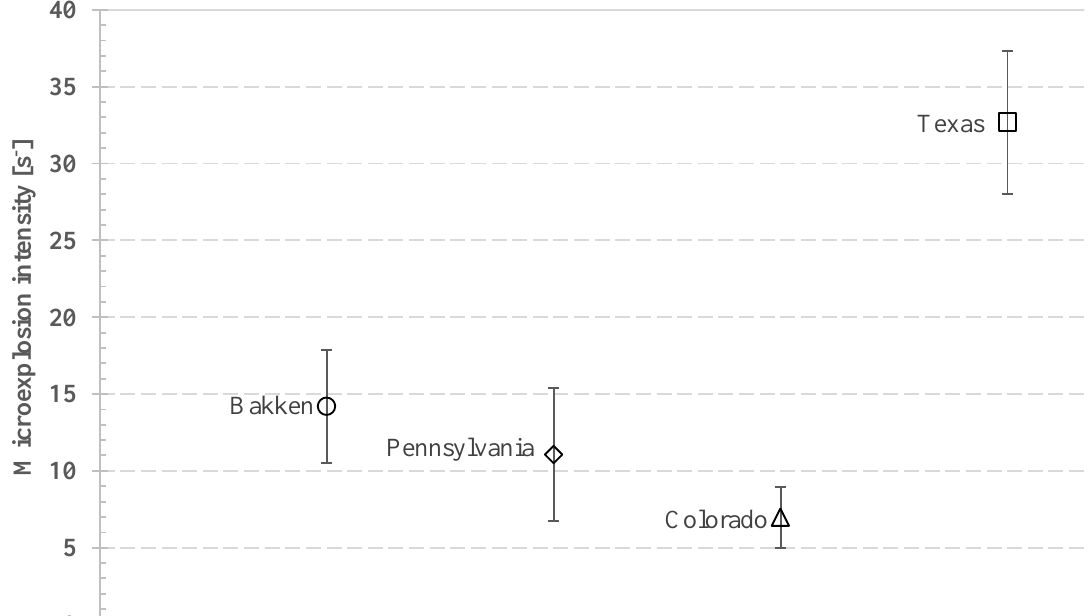
Figure 11. The average microexplosion intensity for various crude oils in Zone III.